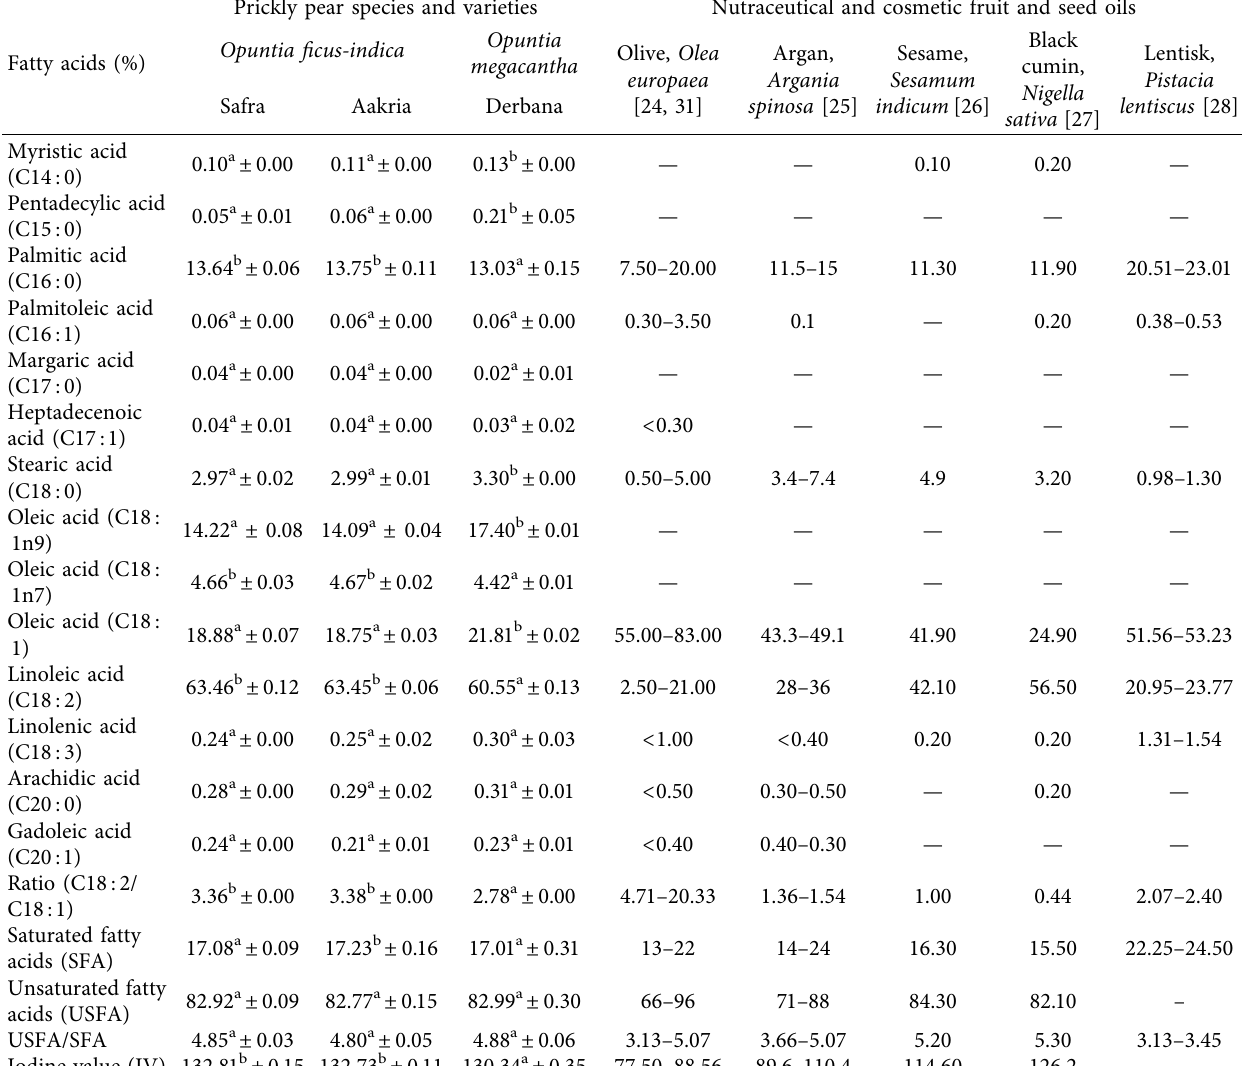
Table 2: Fatty acid composition of seed oils of two species of prickly pear: Opuntia ficus-indica (“Safra” and “Aakria” varieties) and Opuntia megacantha (“Derbana” variety) compared with other nutraceutical and cosmetic oils ∗ . Prickly pear species and Fatty acids (%)